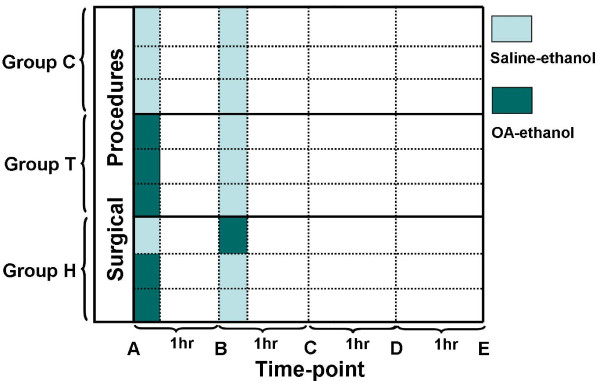
The regimen of oleic acid administration and time-line of the experiment protocol. Time-point A, 30 min after surgical procedure; time-point B, C, D and E, 1 hr, 2 hrs, 3 hrs and 4 hrs after time-point A. Group C received 0.1 ml/kg saline-ethanol solution at time-point A and B respectively; Group T received 0.1 ml/kg OA-ethanol solution at time-point A and 0.1 ml/kg saline-ethanol solution at time-point B; Group H received 0.07 ml/kg OA-ethanol solution followed by 0.03 ml/kg saline-ethanol solution at time point-A and 0.03 ml/kg OA-ethanol solution followed by 0.07 ml/kg saline-ethanol solution at time-point B.